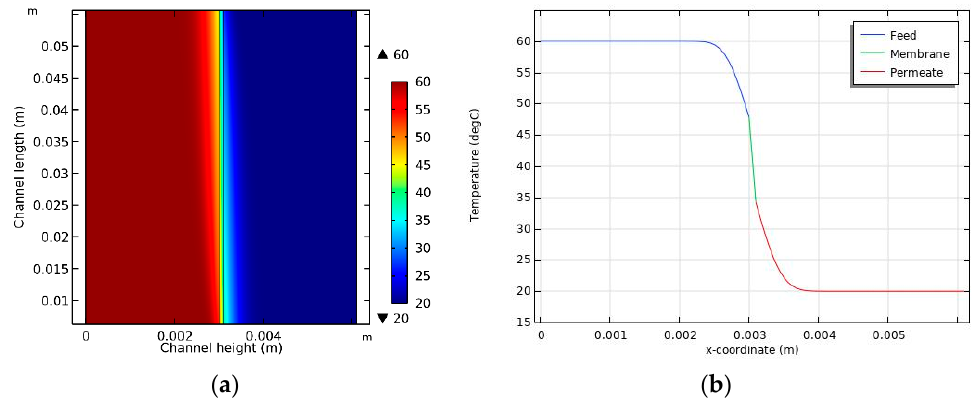
Figure 5. ( a ) Temperature distribution inside the DCMD module and ( b ) temperature variation according to channel height in the middle of the module (y = 0.03 m).